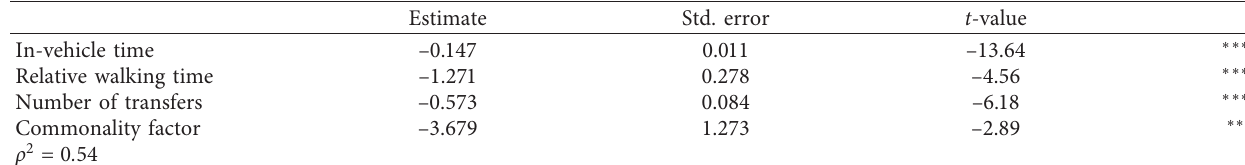
Table 3: Path choice model estimation